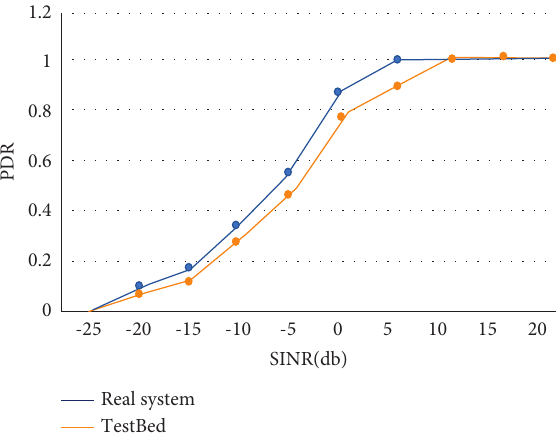
Figure 10: PDR versus SINR in system nodes.